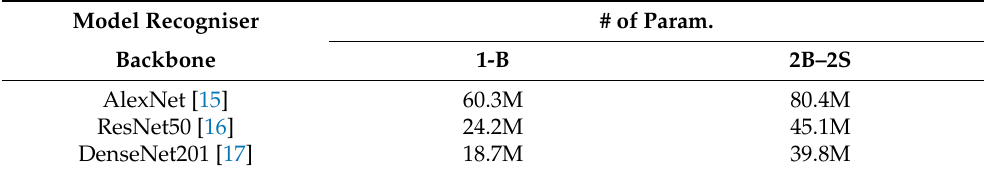
Table 11. Model complexity comparison with different model recognisers. Model